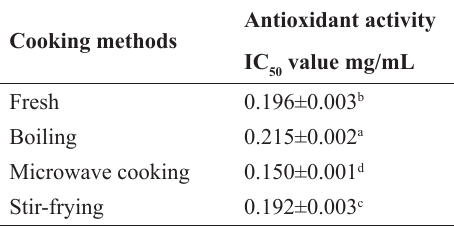
Table 1: DPPH radical scavenging activity of fresh and cooked tomato.